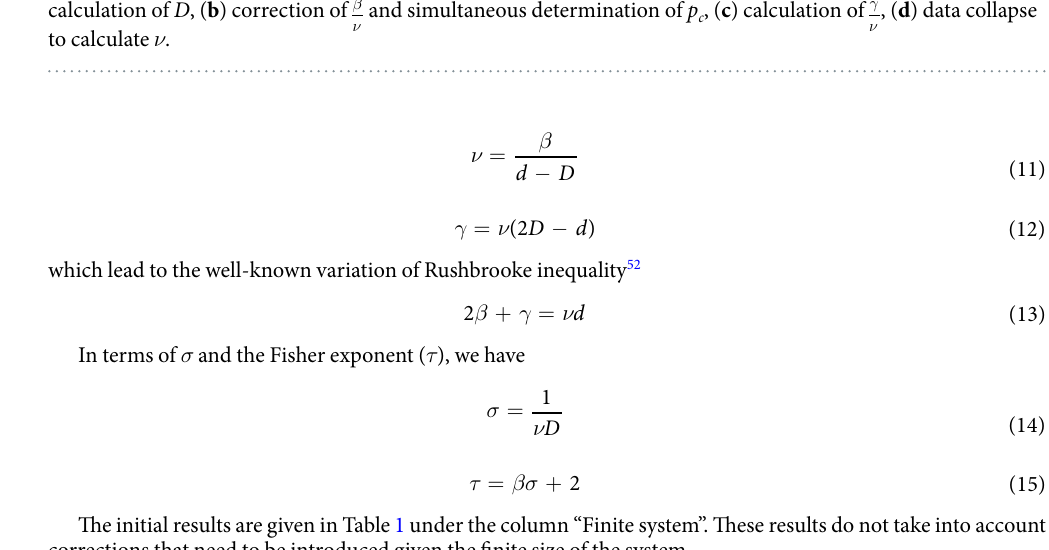
and simultaneous determination of p c , ( c ) calculation of γ ν